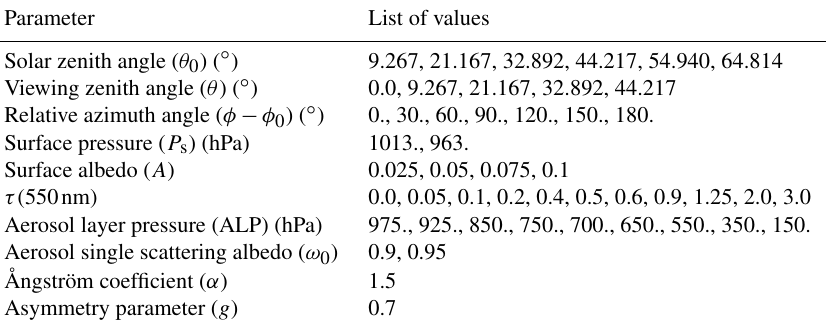
Table 1. Ensemble of parameters and values associated with the synthetic learning data set (see Sect. 3.2). Aerosols are simulated with a Henyey–Greenstein scattering phase function (Hovenier and Hage,